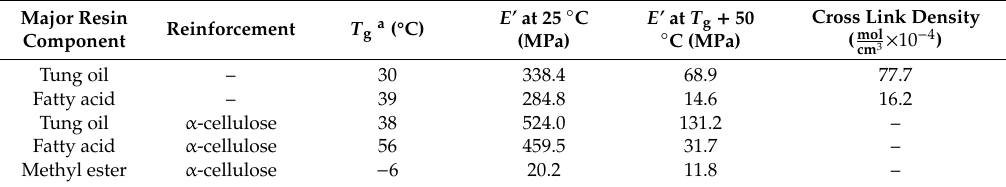
a T g was obtained from the peak of the tan δ